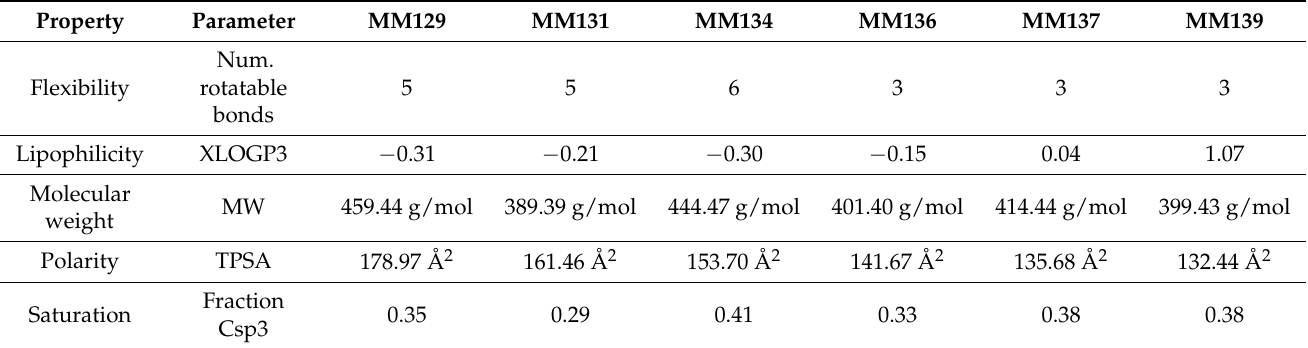
Table 5. Chosen physicochemical properties of tested compounds.